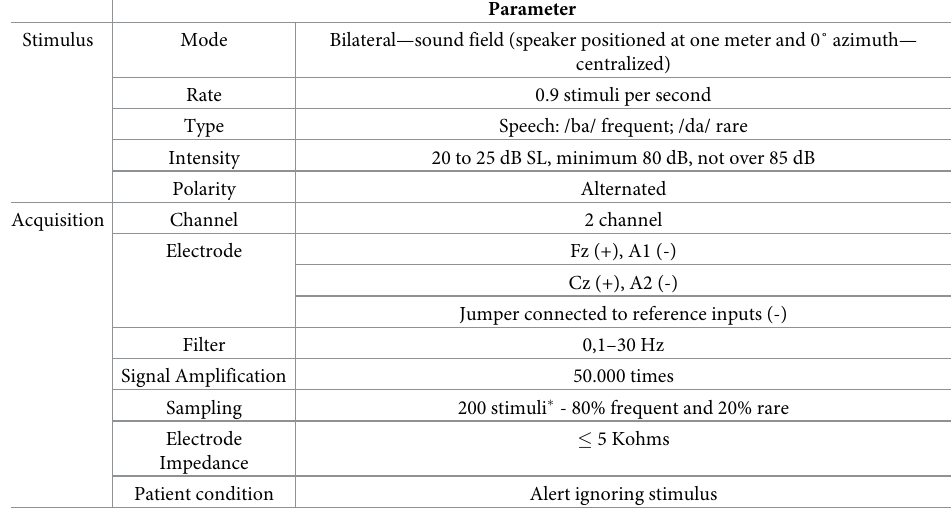
Table 1. Summary of parameters used for the CAEP